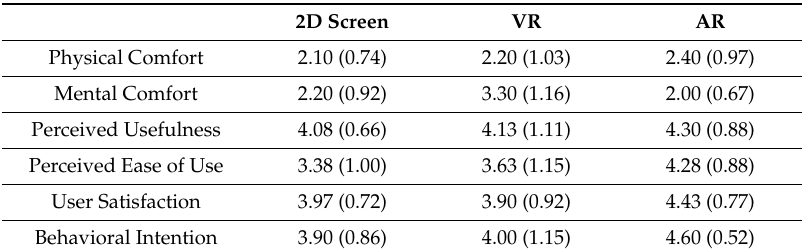
Table 5. User acceptability.